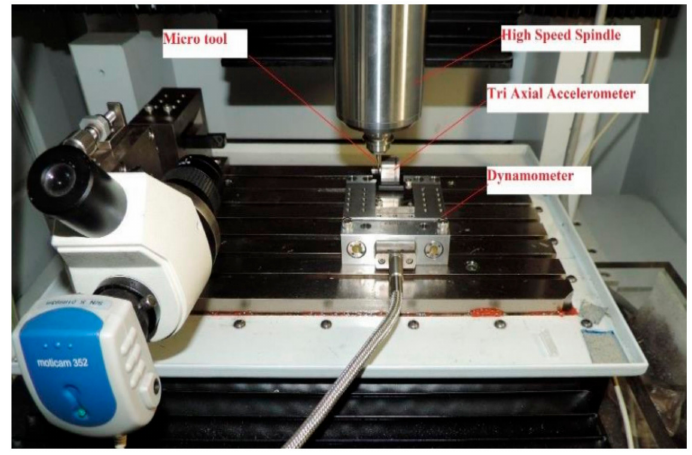
Figure 1. Experimental setup for